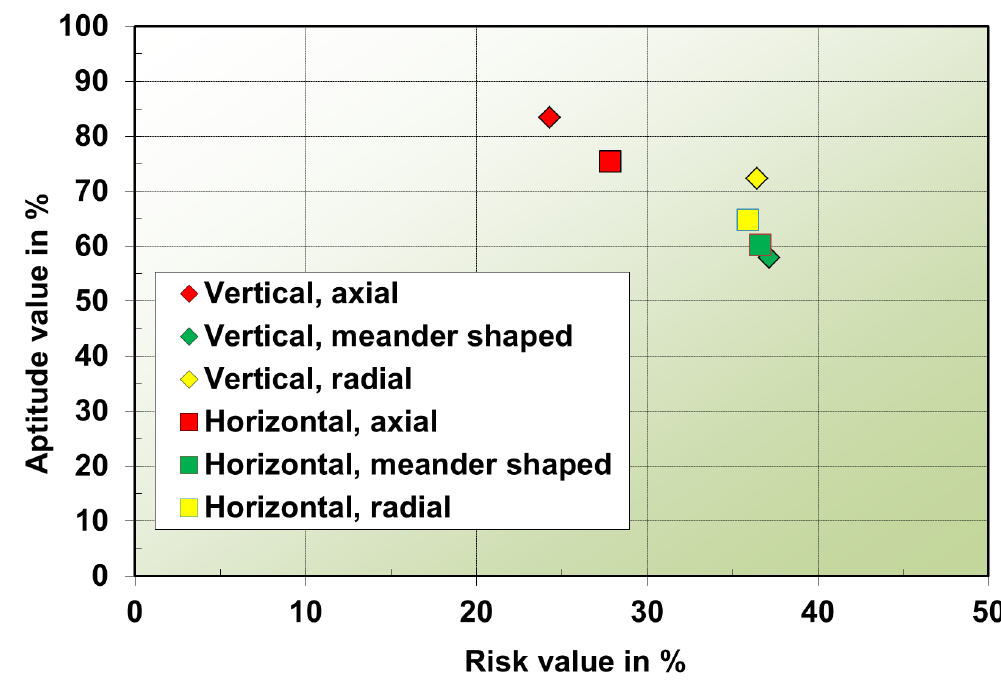
Figure 8. Results of the comparative assessment.